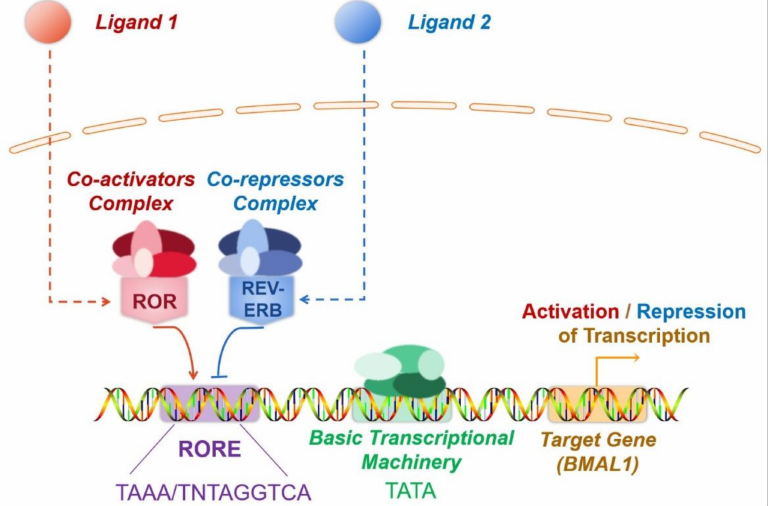
Figure 1. The mechanism of transcriptional modulation mechanism by ROR and REV-ERB. ROR and REV-ERB are ligand-dependent transcription factors. Ligand binding triggers conformational alterations in both ROR or REV-ERB. As a result, they recruit co-activators or co-repressors to ultimately boosts or represses target gene transcription. REV-ERB and ROR are often co-expressed, and both specifically recognise RORE. Consequently, ROR and REV-ERB competitively bind to RORE present in the regulatory region of target genes, forming a mutually antagonistic relationship. In most cases, ROR recruits co-activators and promotes gene transcription, whereas REV-ERB recruits co-repressors and inhibits gene